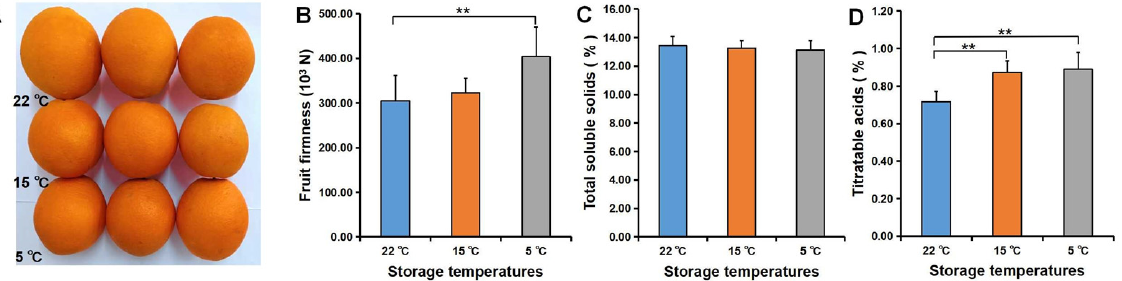
Figure 10. The firmness, total soluble solids, and titratable acids of navel orange fruit during stor- age at different temperatures (5, 15, and 22 °C). ( A – D ) Fruit phenotypes ( A ), firmness ( B ), total soluble solids ( C ), and titratable acids ( D ) of navel orange. The error bars represent the mean ± SD ( n = 6). **, p < 0.01.